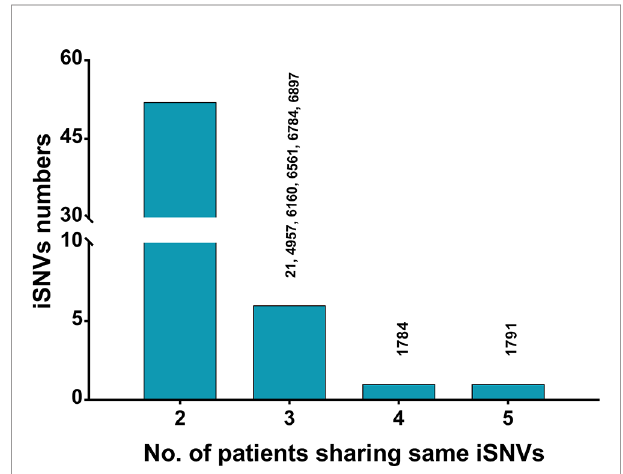
FIGURE 3 | Statistics of shared HPgV-2 iSNV sites among patients. Each bar represents the number of iSNV sites occurring in a given number of patients ( ≥ 2). Sites shared in ≥ 3 samples are shown on top of the bars.